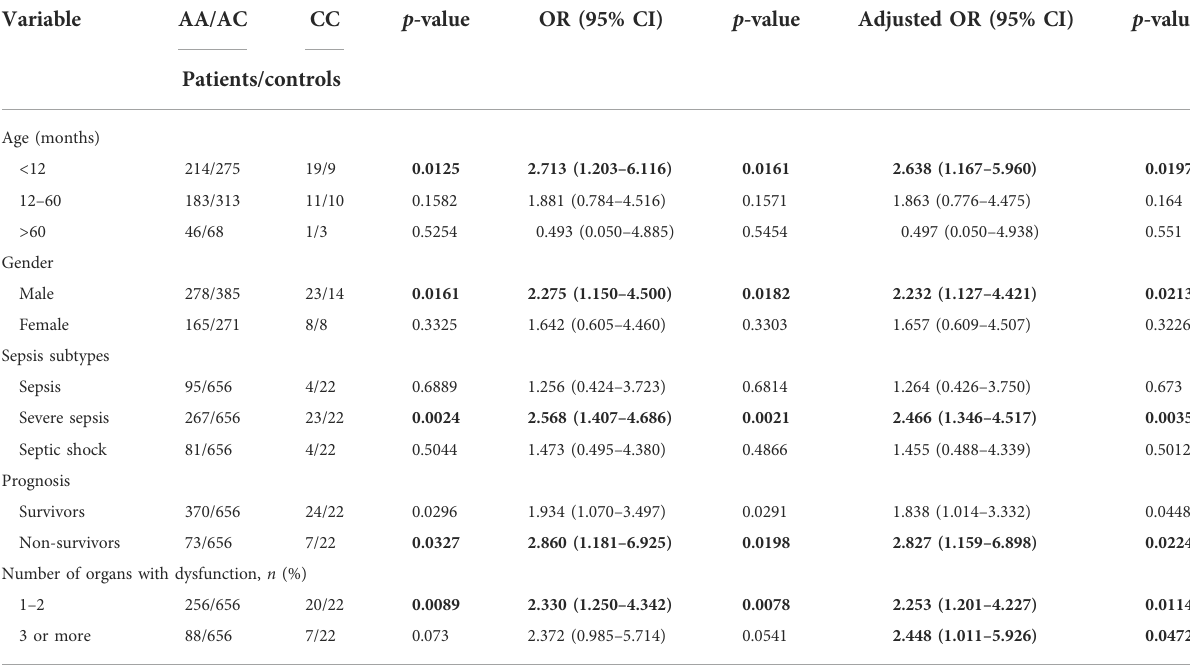
TABLE 4 Strati fi cation analysis of susceptibility in sepsis patients.